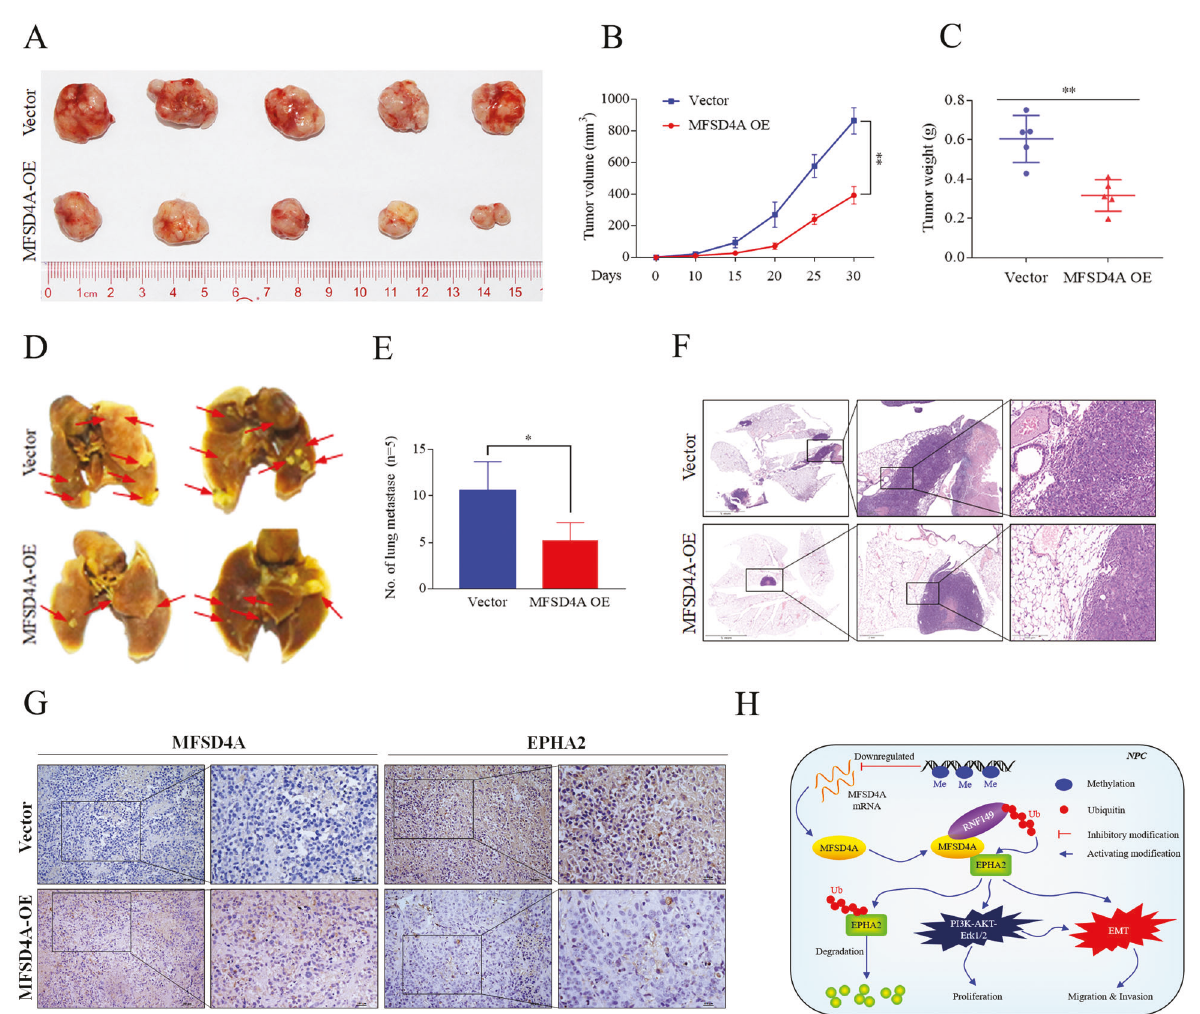
Fig. 7 Animal experiments and a diagram of the model mechanism. A , B Tumor growth models. A The tumor volume of mice was reduced after overexpression of MFSD4A ( B ). C Tumor weight was reduced in mice after overexpression of MFSD4A. D Mouse lung metastasis models. The red arrows represented the metastatic areas. E The number of pulmonary metastases of mice was compared between mice overexpressing MFSD4A and the control group. F Hematoxylin-eosin staining assays demonstrating that overexpression of MFSD4A induced fewer lung metastases compared with those in the control group. G Immunohistochemistry assays showing the expression of MFSD4A (left) and EPHA2 (right) in mouse tissues overexpressing MFSD4A and the control group. H Schematic diagram of the mechanism of MFSD4A in NPC. * P < 0.05, ** P <